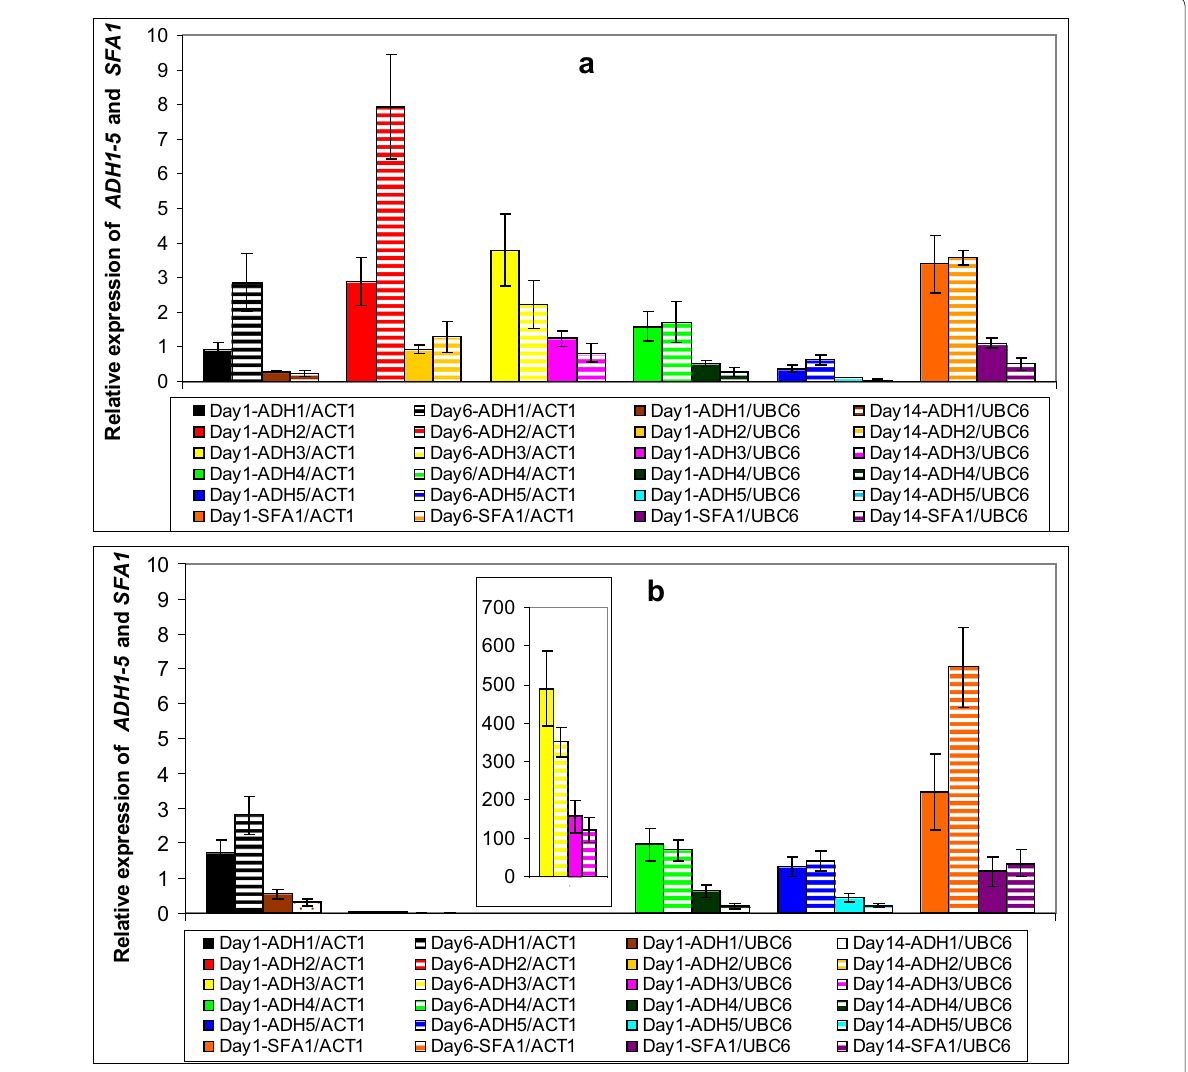
Fig. 4 Expression of genes ADH1 - ADH5 and SFA1 during Debina must fermentations. a Strain VL1 and b strain Z622. In a and b : gene expression on day 1 was normalized against the expression levels of both ACT1 and UBC6 genes, whereas: (i) on day 6 expression values were normalized against ACT1 and (ii) on day 14 against UBC6. In each set of values, the first bar corresponds to day 1 normalized against ACT1 , second bar to day 6 normalized against ACT1, third bar to day 1 normalized against UBC6 and fourth bar to day 14 normalized against